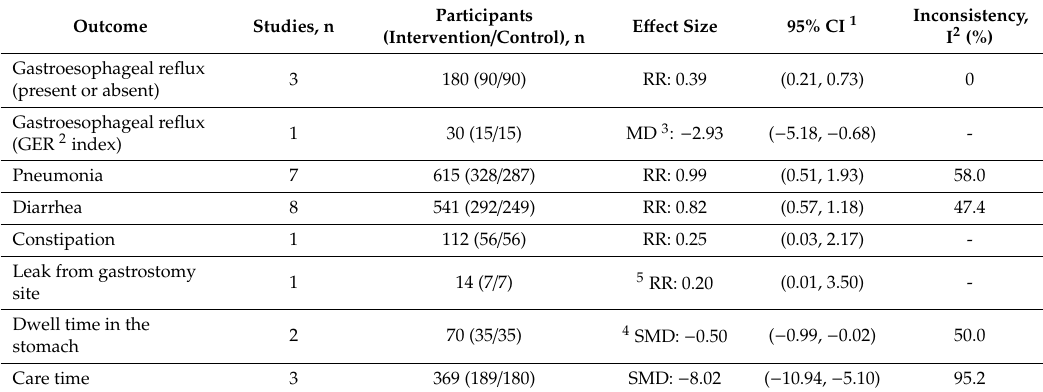
Table 2. Summary of meta-analysis for